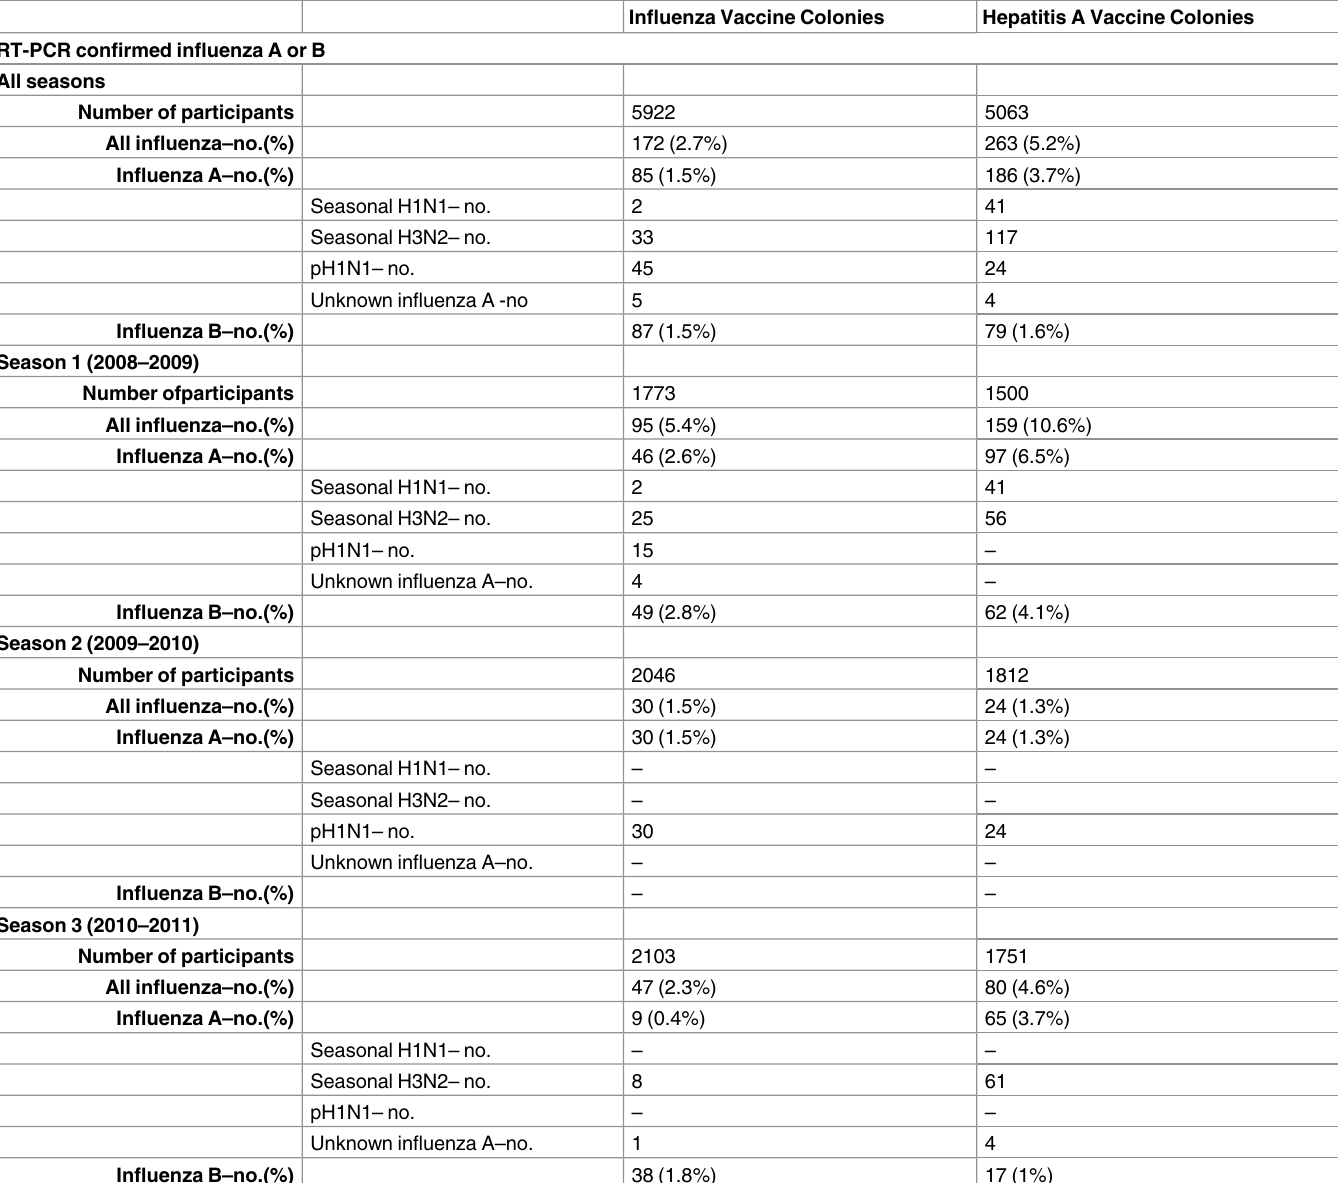
Table 2. Influenza A or B Detectedin All Participants in the Study a